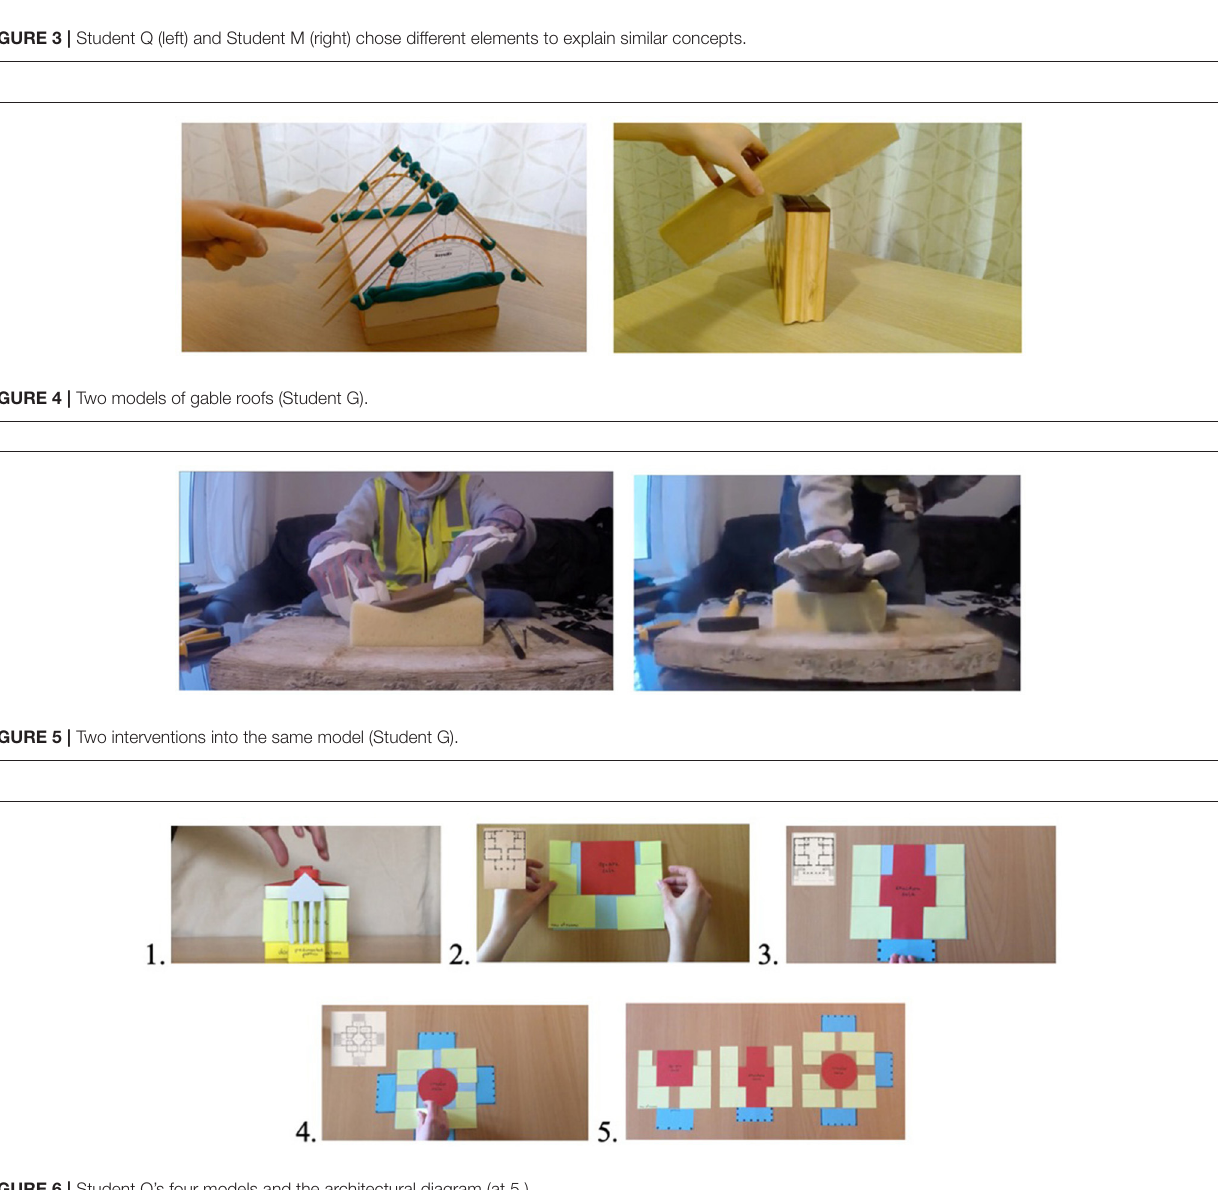
FIGURE 6 | Student O’s four models and the architectural diagram (at